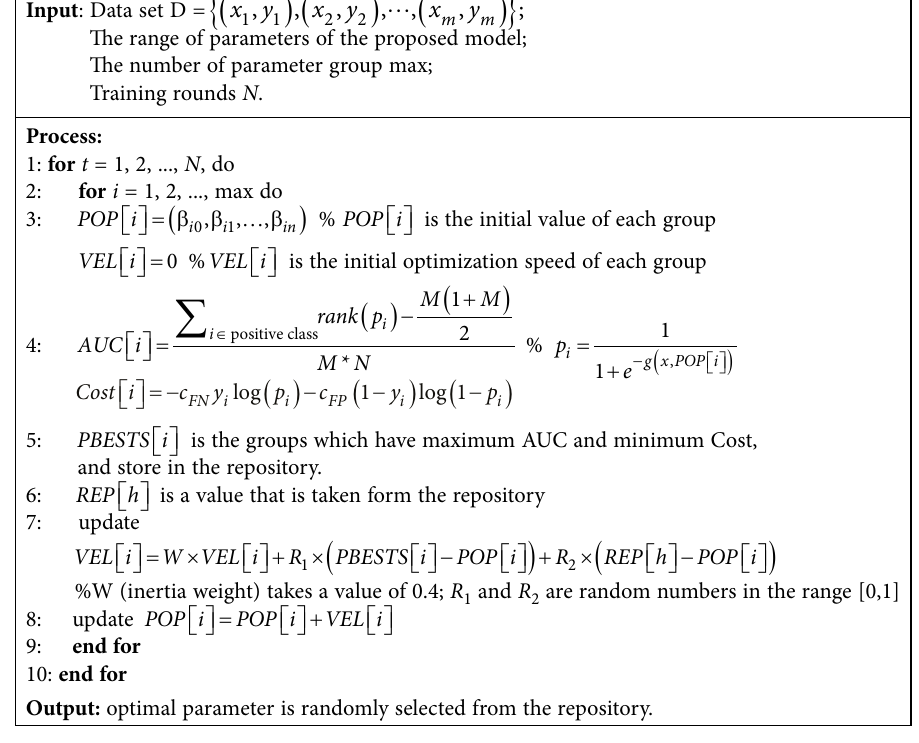
Figure 6. Pseudocode for the proposed model solved using the MOPSO